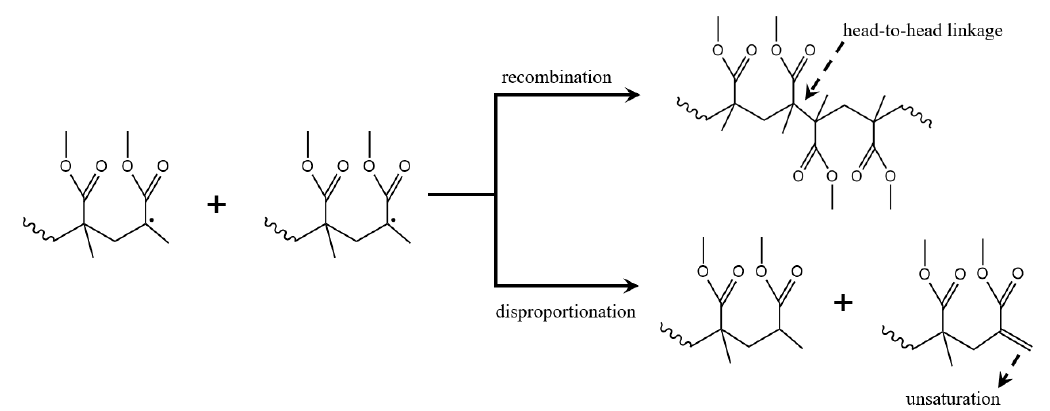
Figure 4. Top: termination by recombination of two head PMMA macroradicals, giving rise to the formation of head-to-head linkages or structural defects; Bottom: termination by disproportionation of two head PMMA macroradicals leading to the formation of unsaturations.